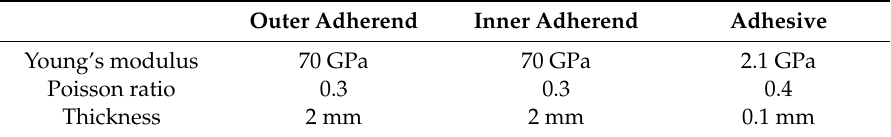
Table 1. Material properties and thickness of the double lap joint for the validation